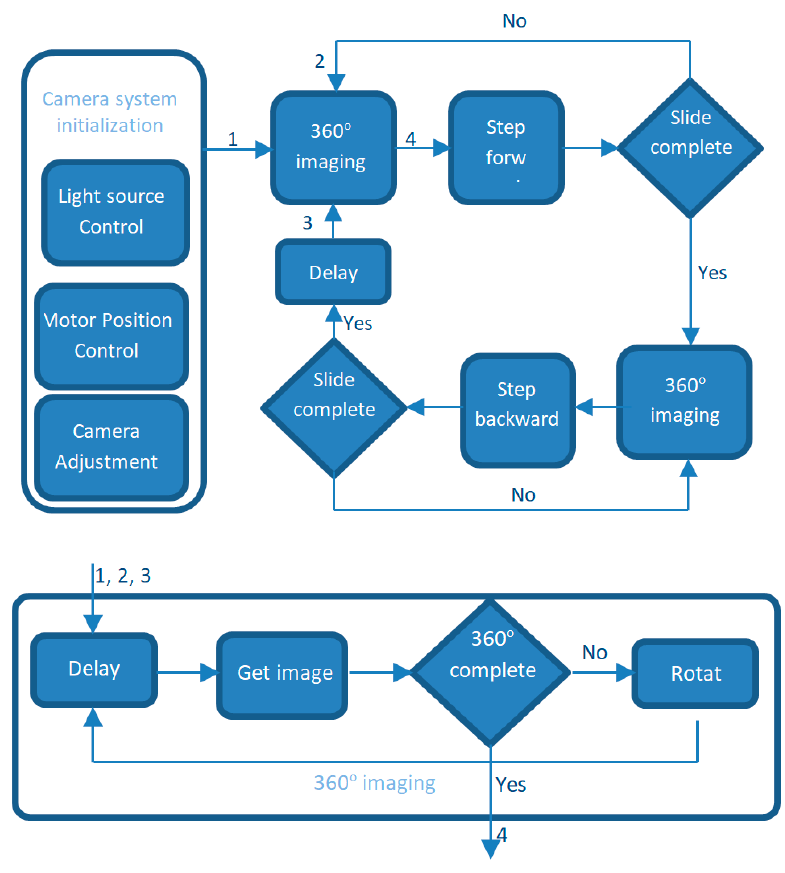
Figure 5. Flowchart of imaging acquisition.